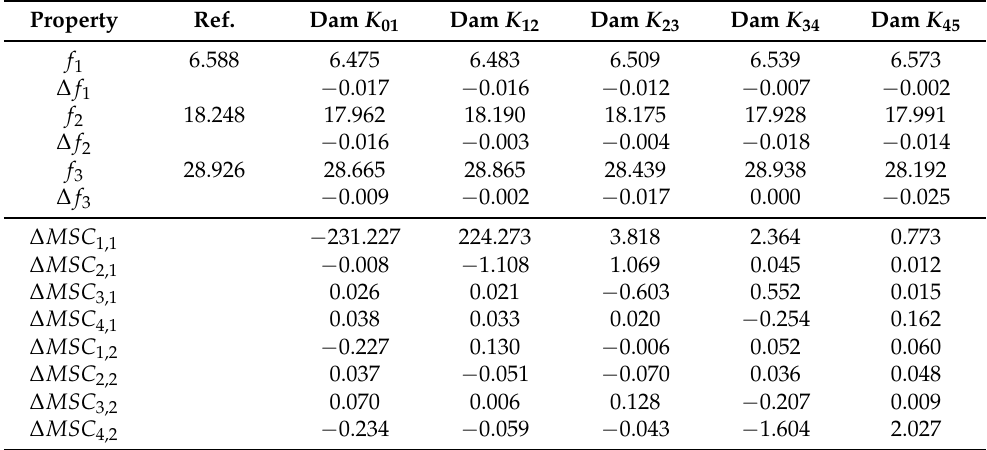
Table A2. Theoretical values of OMA-based DSFs, when damage (stiffness reduction of 10%) is applied in single links of the spring-mass model, which is used in Section 3.1. The change in the first three natural frequencies ( ∆ f n , n = 1–3) is reported as well as the mode-shape curvature, ∆ MSC ij , of the first two modes ( j = 1–2) at the first four degrees of freedom ( i = 1–4). Property